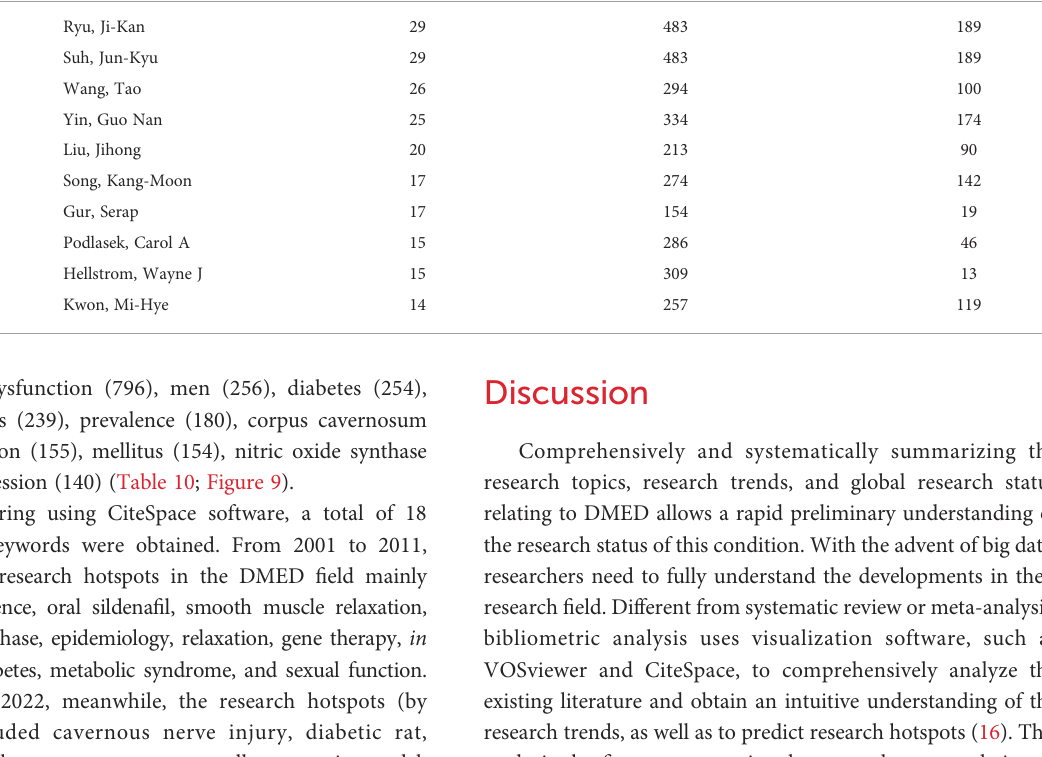
TABLE 5 The number of articles published by the top 10 authors.